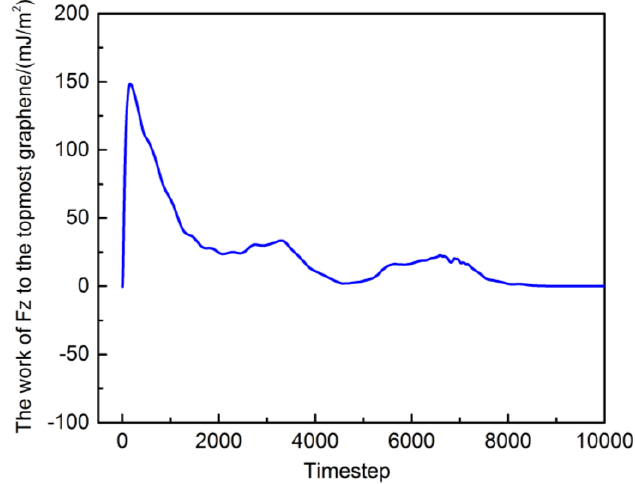
Figure 14. The work of Fz to exfoliate the topmost layer of graphene when the upward velocity is 10.16 Å /ps.